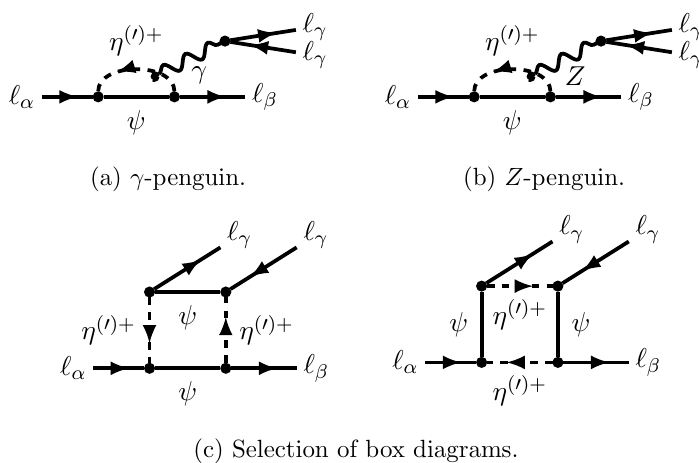
(c) Selection of box diagrams. Figure 3 . Diagrams contributing to ‘ (cid:11)